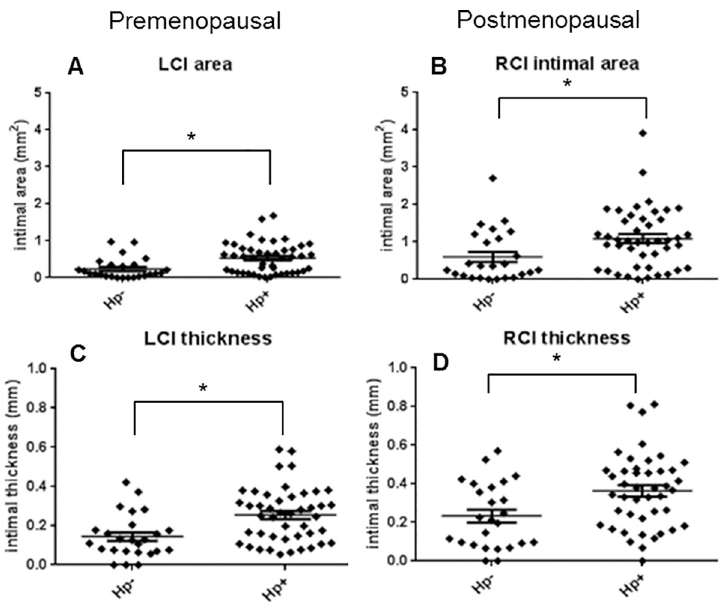
Fig 8. Premenopausal and postmenopausal effects of H . pylori on atherosclerotic plaque thickness. Common iliac artery plaque intimal areas and maximum intimal thicknesses were measured at premenopausal (A and C, n = 70) and postmenopausal time points (B and D, n = 69). Hp, H . pylori; LCI, left common iliac; RCI, right common iliac). Graphs show mean +/- standard error of the mean. � P < 0.05.